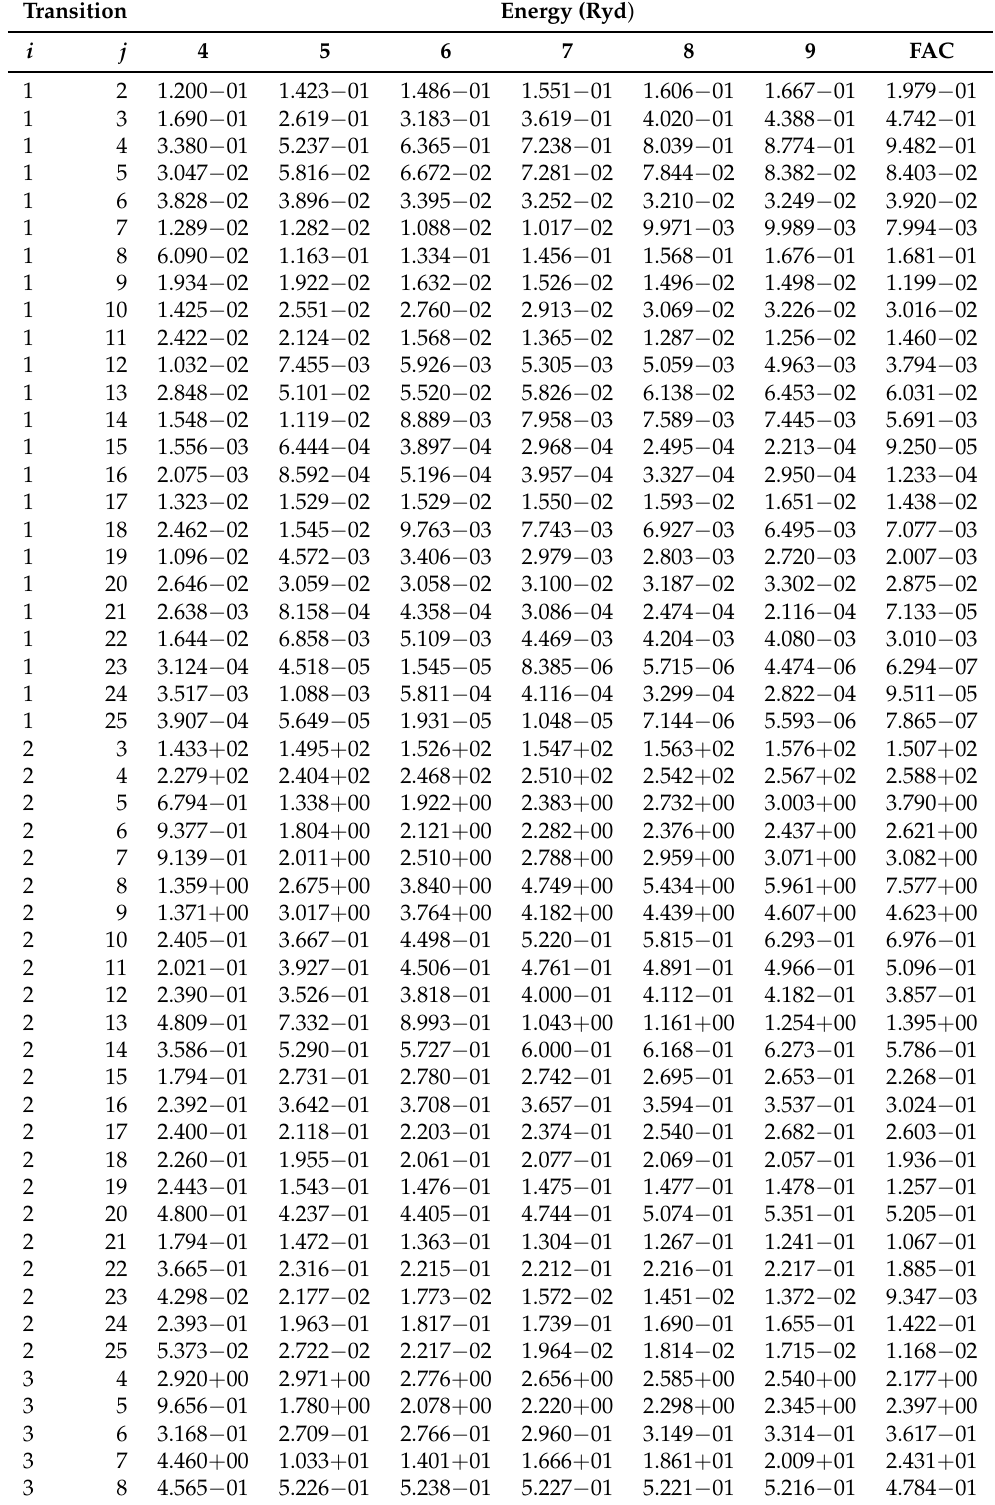
Table 3. Collision strengths for transitions in He II from our calculations with the DARC code. Presently calculated results from FAC are also listed at a single incident energy of ∼ 9 Ryd. ( a ± b ≡ a × 10 ± b